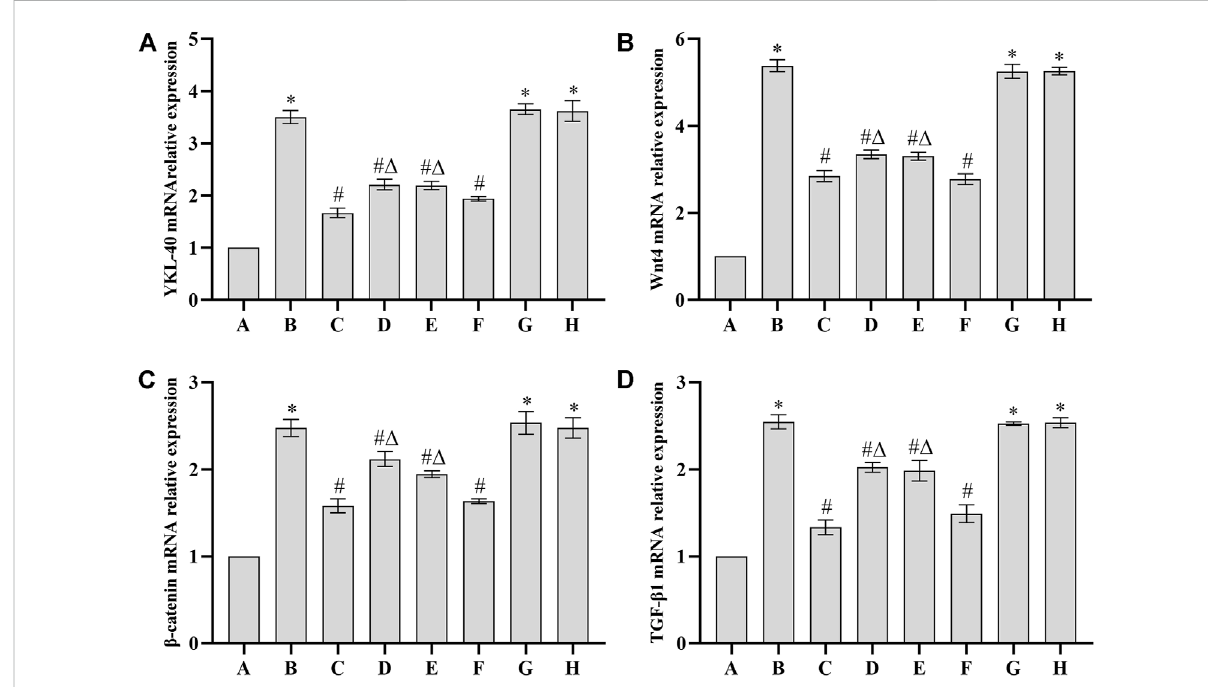
FIGURE 3 Comparison ofmRNAexpression ofYKL-40 (A) , Wnt4 (B) , β -catenin (C) andTGF- β 1 (D) ineachgroup( n =10, (cid:1) x ± s ).Note: A.Blank groupB. DN modelgroupC.IrbesartangroupD. Cornusof fi cinalis groupE.WineCornusof fi cinalisgroupF.WinehoneyCornusof fi cinalisgroupG.Auxiliarywine group H. Auxiliary wine honey group.